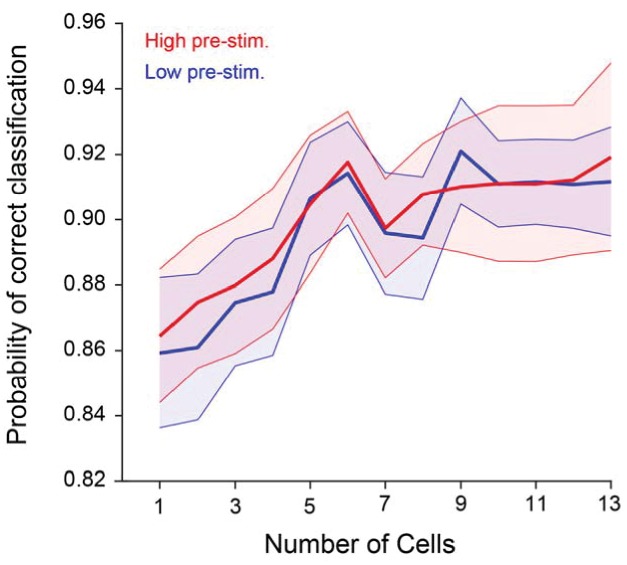
Probability of correct classification (PCC) as a function of population size when baseline-subtracted evoked responses to the target and test stimuli are used.PCC does not depend significantly on pre-stimulus activity for any population size (p>0.1; two-way repeated measures ANOVA).